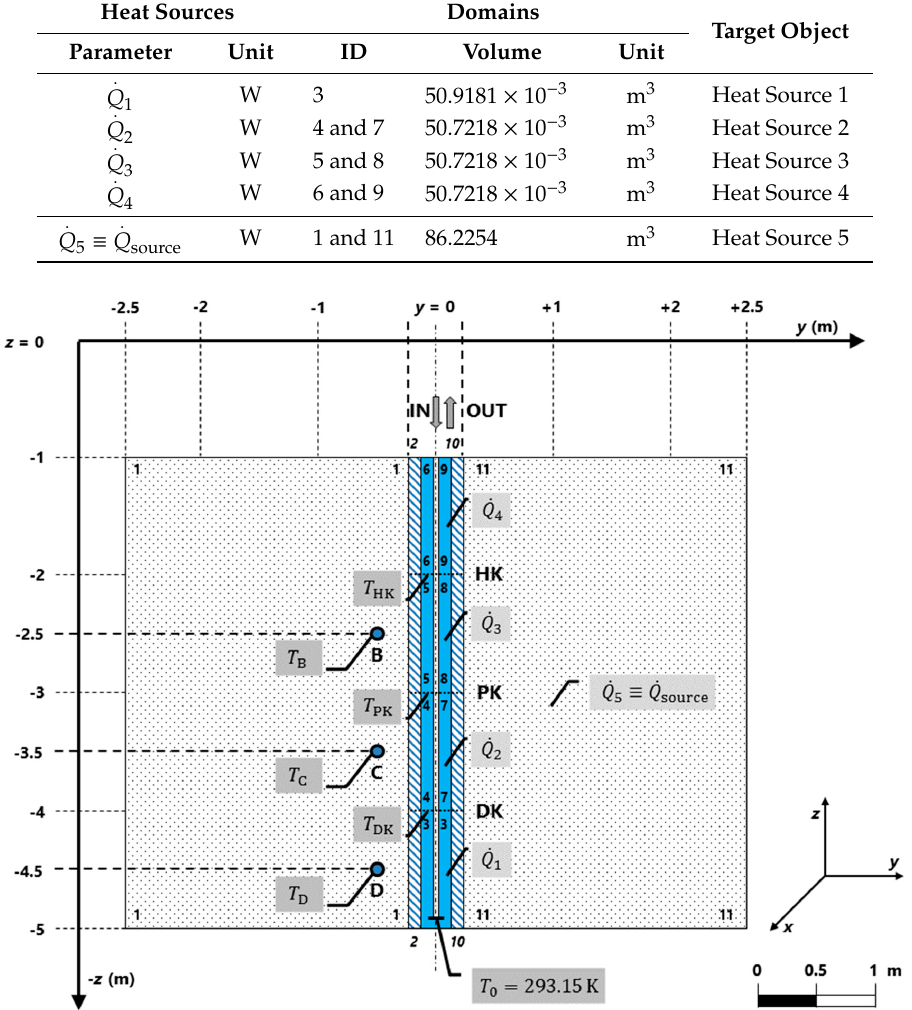
Table 3. Mathematical model—globally defined parameters of the model in the form of heat sources and their implementation in COMSOL (i.e., the heat sources, domains, and target objects).